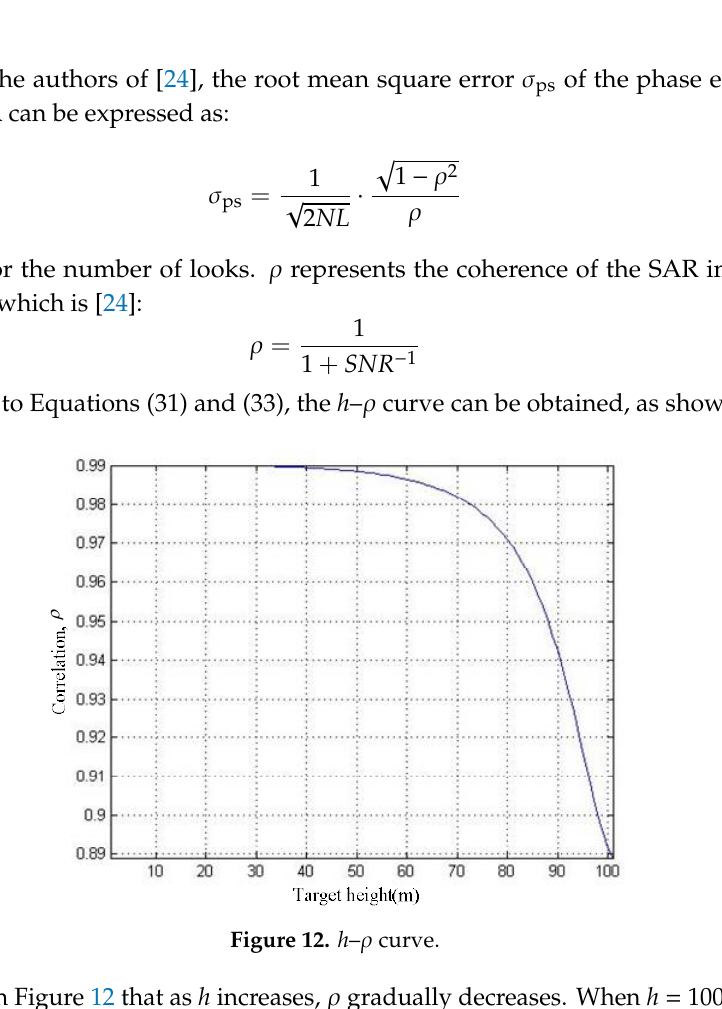
Figure 11. h–S loss curve.